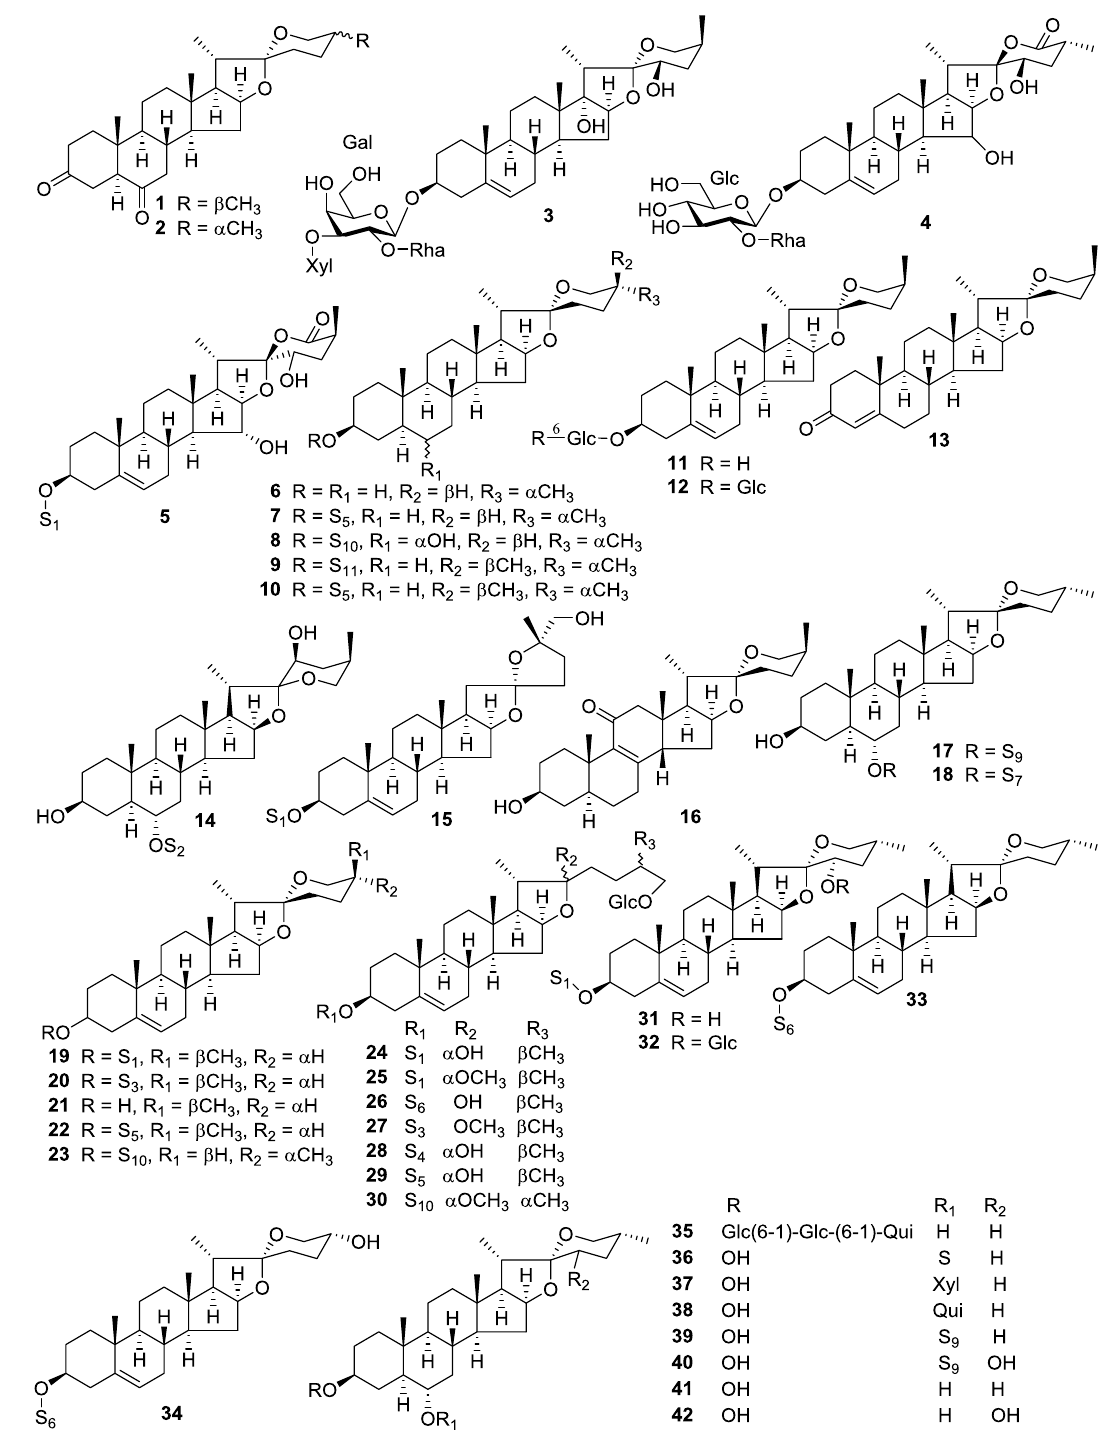
Fig. 1 Steroidal saponins 1 – 134 from Nuatigenosido ( 15 ) from the roots of S. sisymbriifolium presented anti-hypertensive effect in experimental hyper- tensive rats [291]. Dioscin ( 19 ) showed antimelanogen- esis effect on α-melanocyte stimulating hormone (α-MSH)